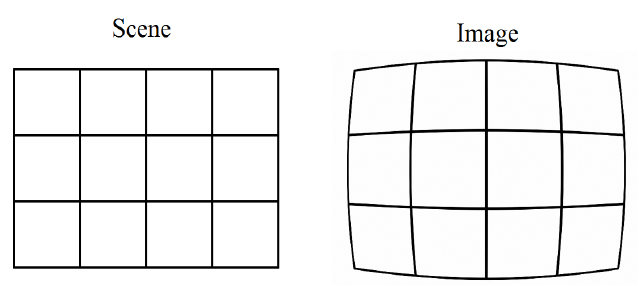
Figure 14. Lens distortion. ( Left ) Original scene; ( Right ) Distorted